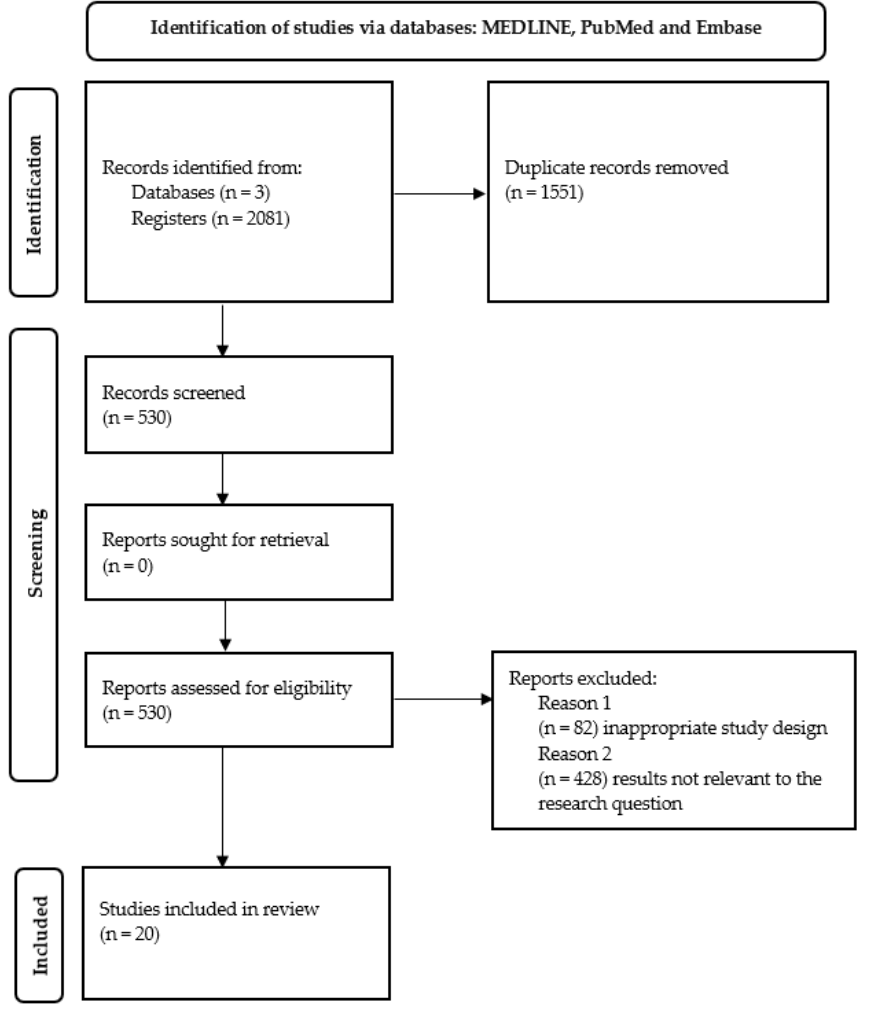
Figure 1. Flow chart of selection process.